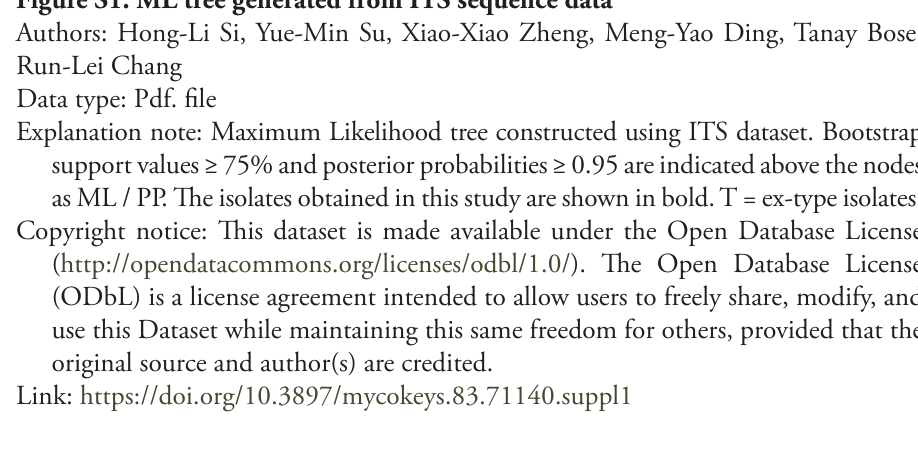
Figure S1. ML tree generated from ITS sequence data